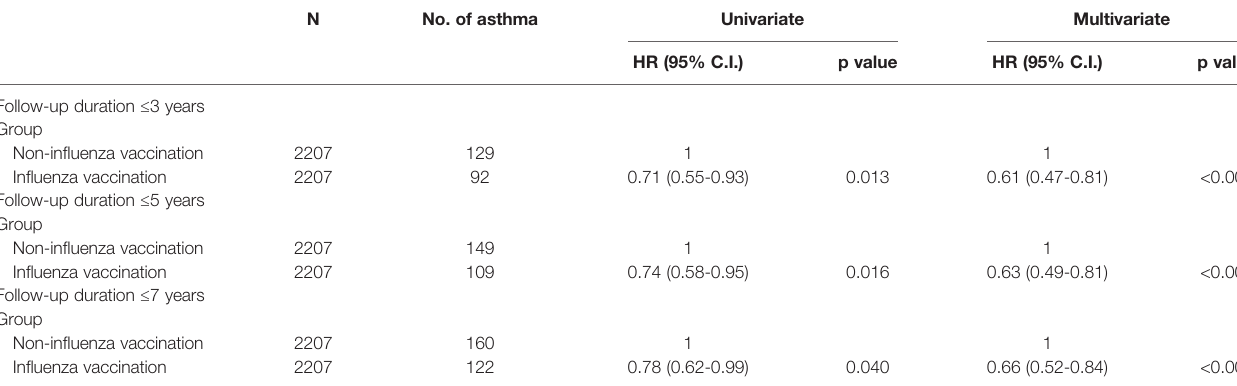
TABLE 4 | Sensitivity analysis of the association between in fl uenza vaccination and asthma